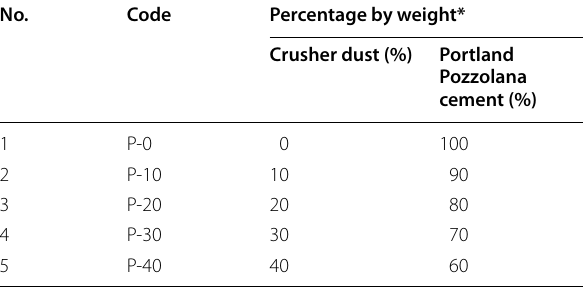
Table 4 Naming and proportioning of cement